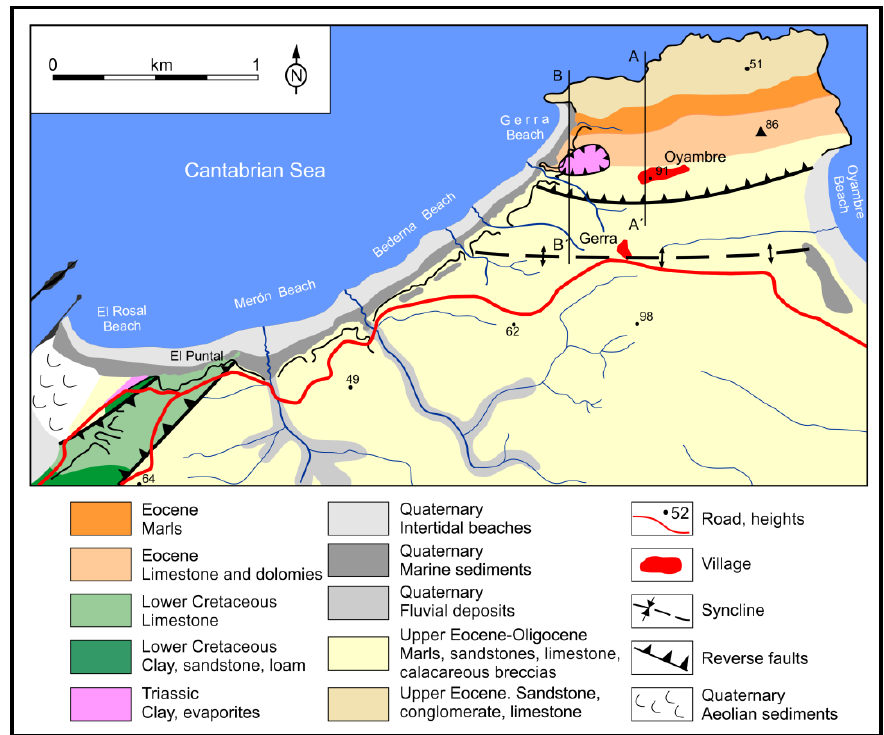
Figure 2. Geological schematic of the SanVicente-Merón coastal system [41,42].